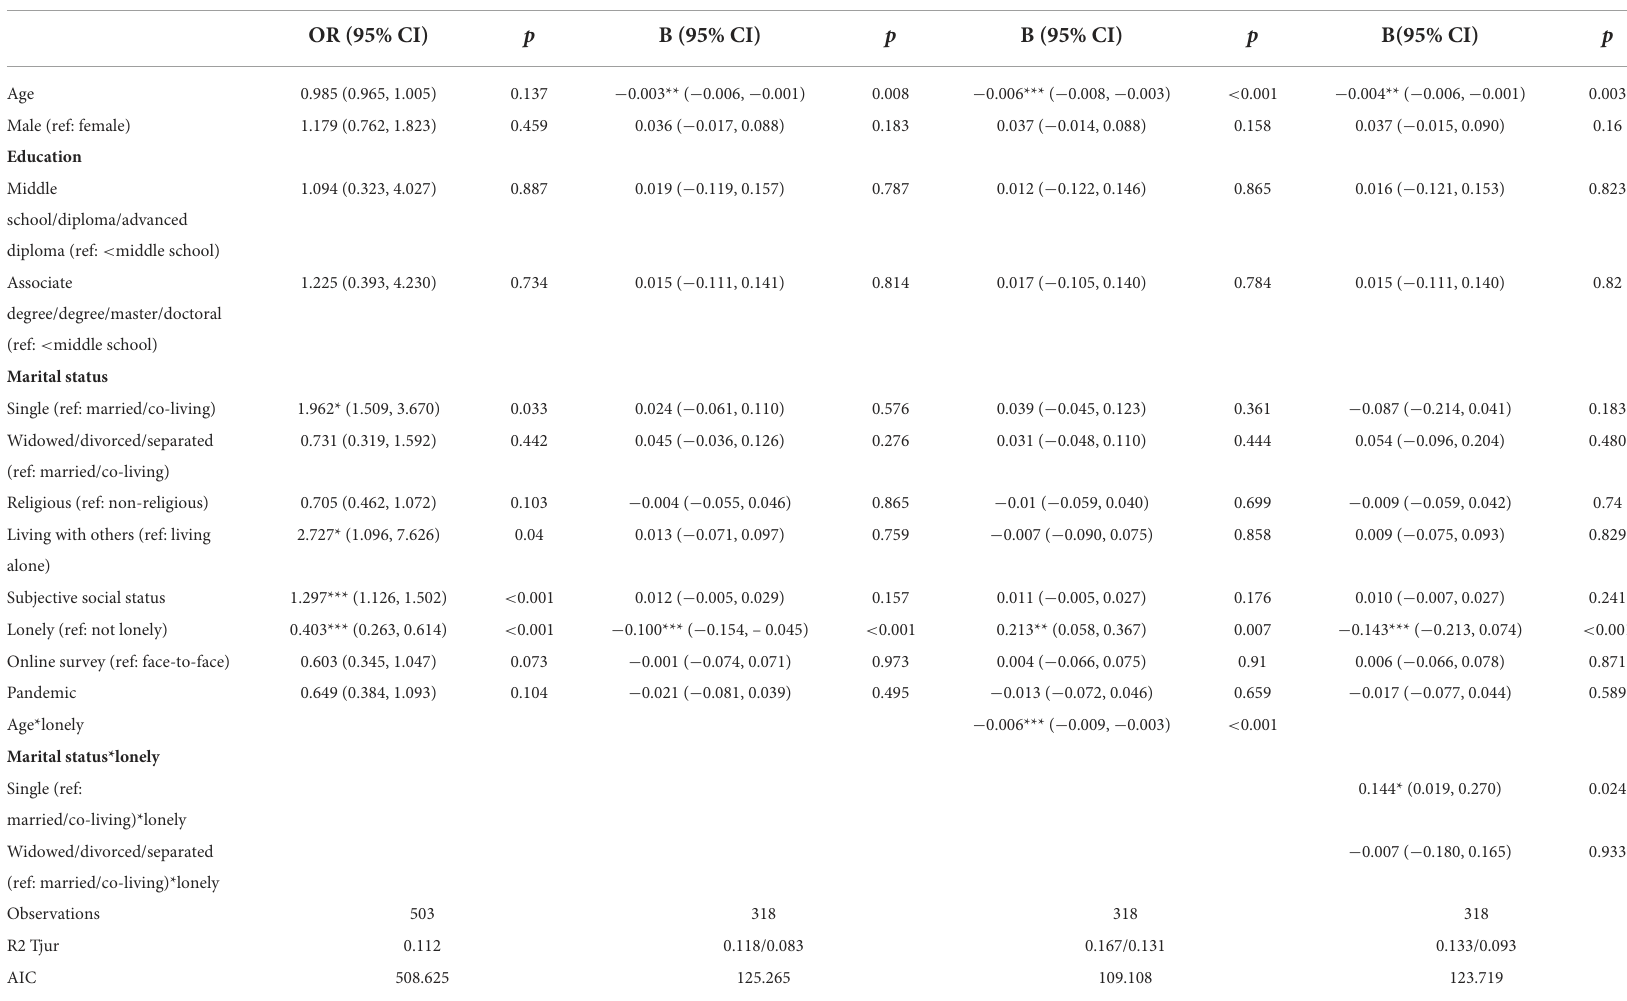
TABLE 4 Two-part models of factors associated with EQ-5D-5L HK index scores. Predictors Logistic regression